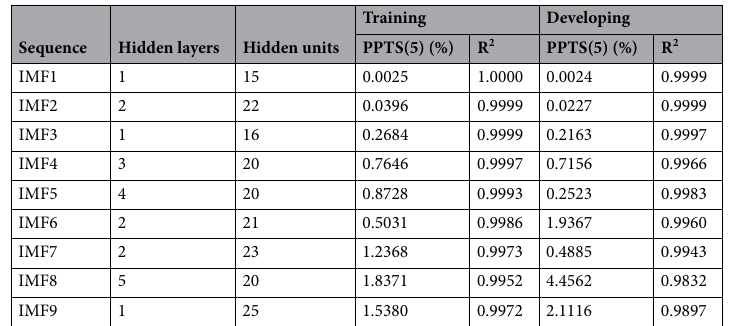
Table 2. Results of evaluation criteria with different hidden layers and hidden units for